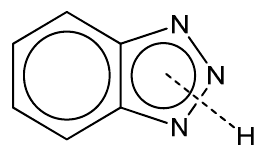
Figure 5. Resonating form of BTAH (benzotriazole).